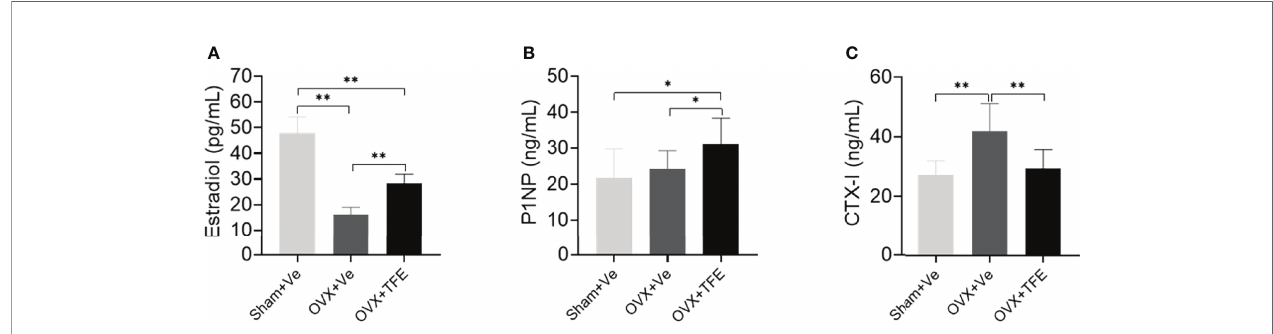
FIGURE 4 | Effects of TFE treatment on (A) 17 b -estradiol, (B) P1NP, and (C) CTX-I. Values are presented as mean (SD; Sham, n = 11; OVX, n = 10; TFE, n = 11). CTX-I, C-terminal telopeptides of type I collagen; P1NP, type 1 collagen amino propeptide; OVX, ovariectomy; Sham, sham-operation; TFE, total fl avonoids of Epimedium; Ve, vehicle. TFE treatment inhibited bone turnover in OVX rats. Serum 17 b -estradiol was signi fi cantly reduced while levels of CTX-I were higher in OVX rats than in Sham rats. * P <0.05 and ** P <0.001 by One-way ANOVA